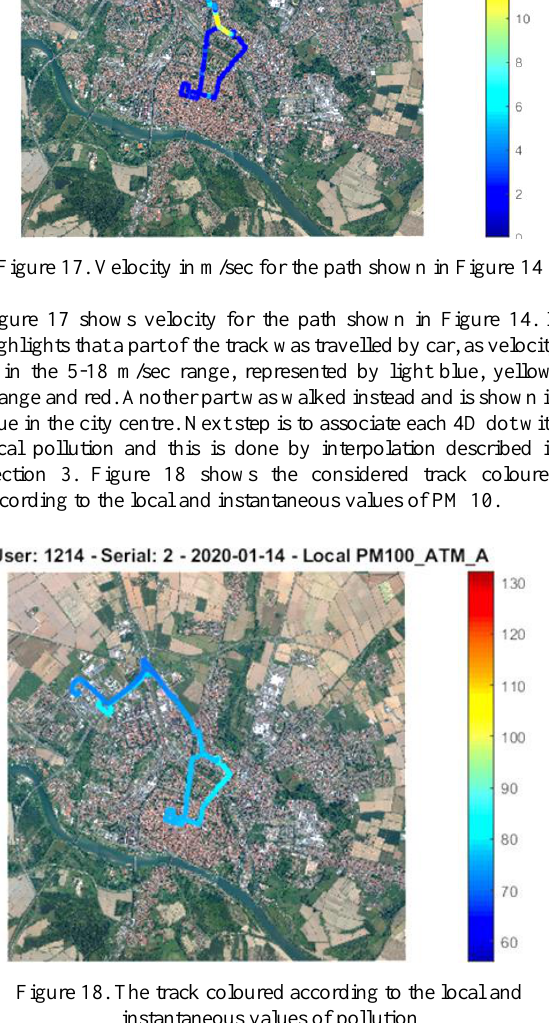
Figure 15. Excerpt from the stored tracks data